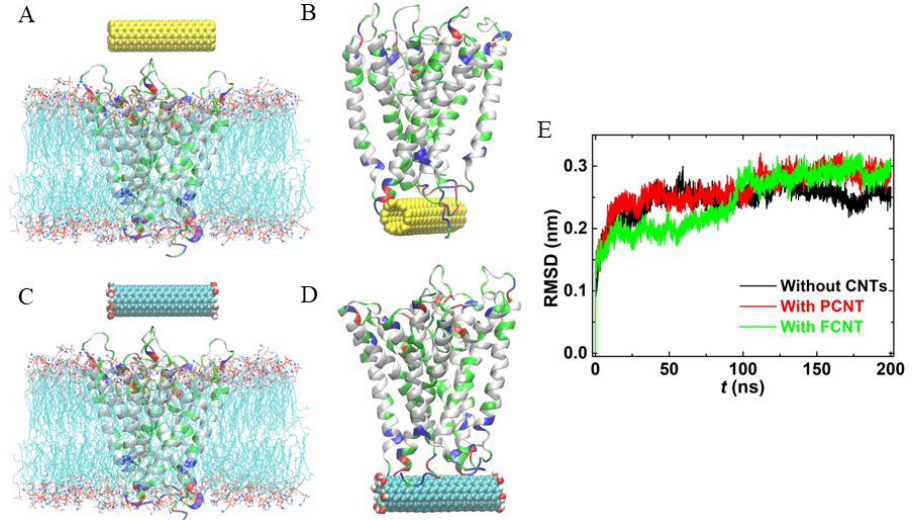
Figure 6. The effects of CNTs on membrane protein. ( A , C ) The initial configurations, where water molecules are not shown for clarity. ( B , D ) The structures of CNT-KcsA complexes. ( D ) root-mean-square-deviations (RMSDs) of KcsA in the lipid bilayer with or without CNTs.